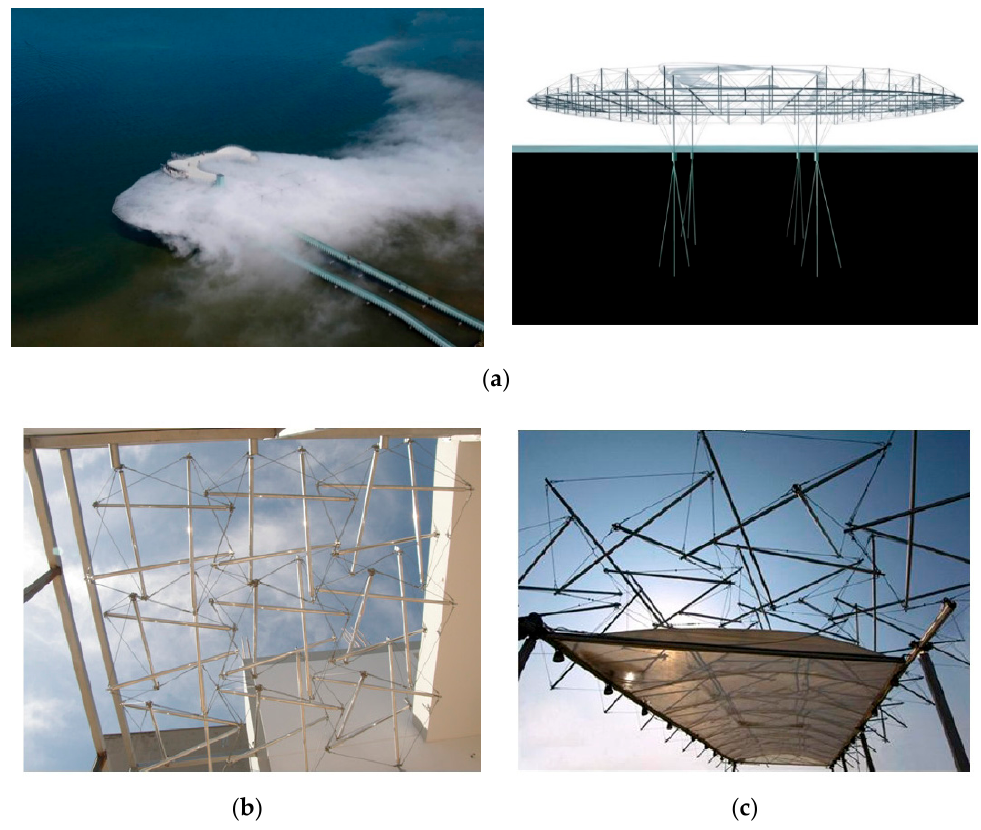
Figure 4. Practical applications of tensegrity in civil engineering: ( a ) Blur Building [46], ( b ) a patio roof of a bank annex (Athens, Greece) [47], ( c ) an exhibition pavilion for Patras Cultural Capital of Europe (Patras, Greece)